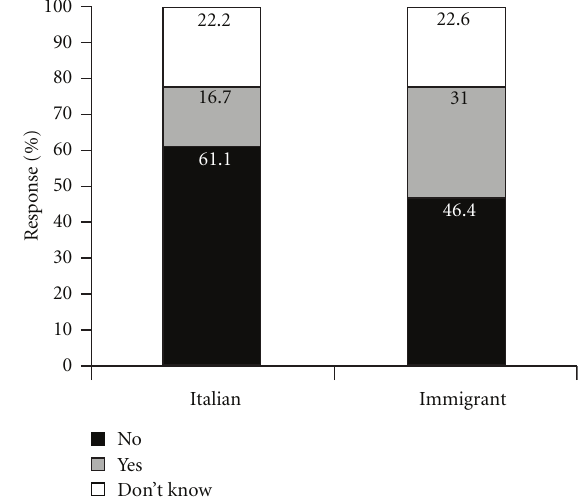
Figure 2: Patients’ opinions about whether diet was di ff erent from that of pregnant women without diabetes. The di ff erences between Italian and immigrant pregnant women are significant ( P < 0 .